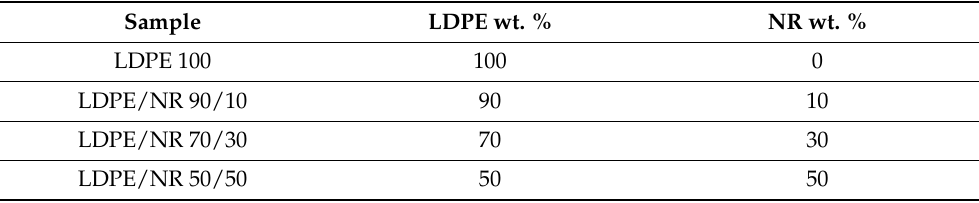
Table 1. Compositions of the LDPE/NR